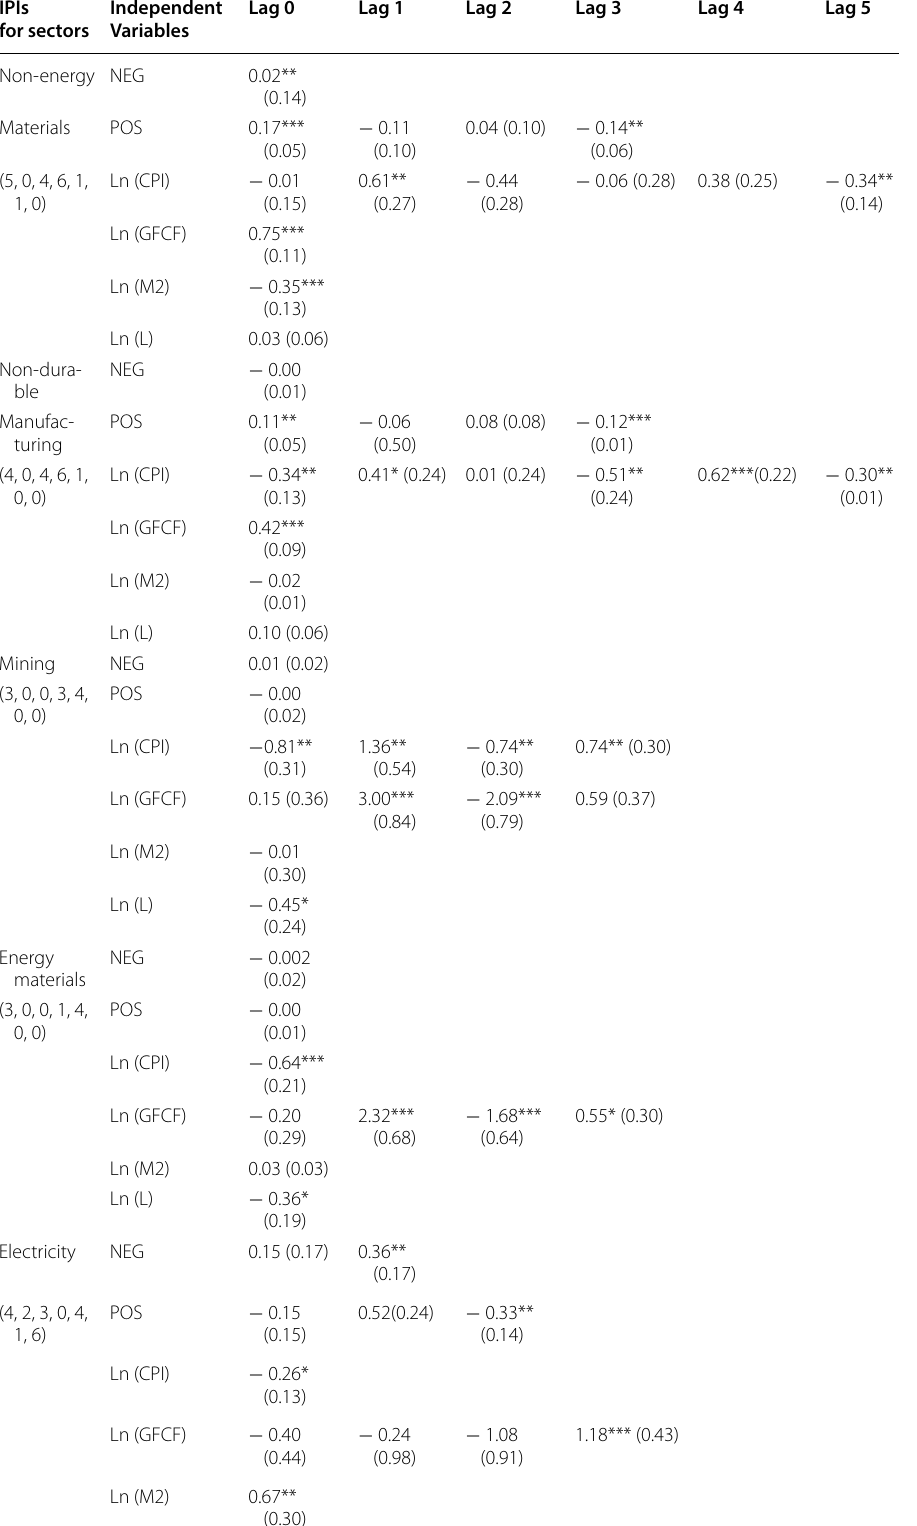
Table 2 Short-run NARDL estimates IPIs Independent for sectors